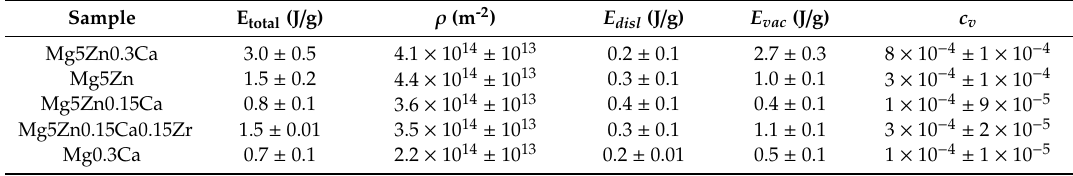
Table 7. Measured and calculated data for DSC peak II. ρ is the dislocation density, c v the vacancy